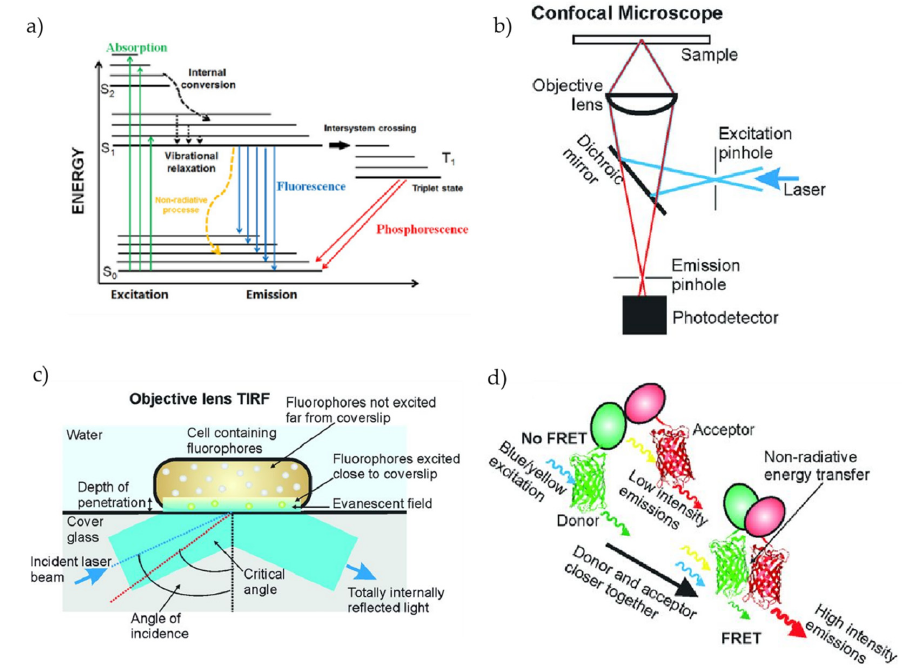
Figure 4. ( a ) Perrin Jablonski diagram of fuorescence and phosphorescence [232]. ( b ) Schematic rep- representation of a confocal microscope [233]. ( c ) Schematic representation of TIRF showing the illumination of fluorophores close to the glass coverslip surface [233]. ( d ) Schematic representation of the FRET principle based on the non-radiative energy transfer which occurs when donor and acceptor dyes pair